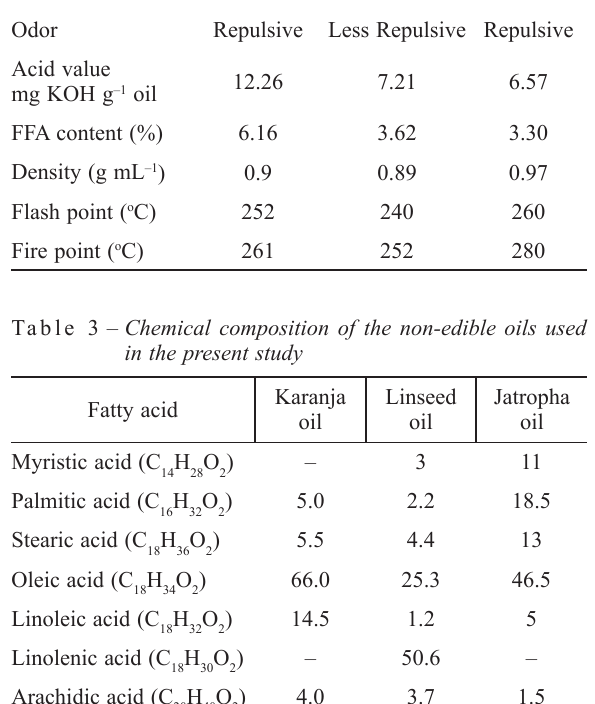
Table 2 – Some characteristic parameters of the non-edible oils used in the present study Characteristic parameter